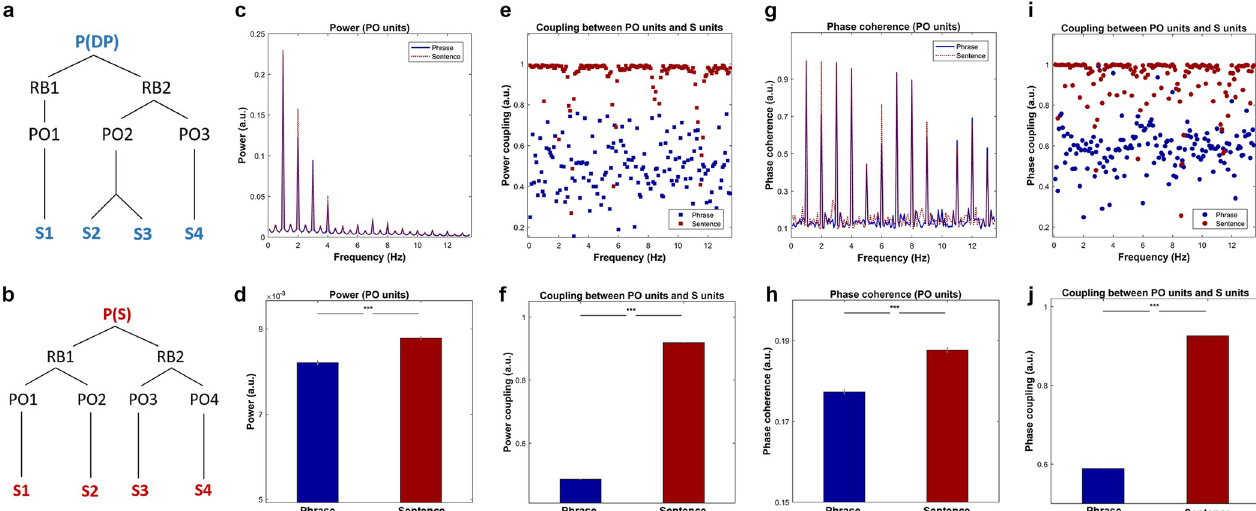
Fig 1. Simulation results based on the time-based binding mechanism. Simulation results based on the time-based binding hypothesis. (a) and (b) The model representation of phrases and sentences, in which the P (Proposition units), RB (Role-filler units), PO (Propositional Object units), and S (syllables units) represent the different types of node in DORA. P(DP) represents the top-level unit is a DP and P(s) represents the highest-level unit is a sentence. (c) Simulation results on power, in which the red dotted line and blue solid line represent the frequency response of the sentences and the phrases, respectively. The shading area covers 2 SEM centered on the mean. (d) Statistical comparison on the frequency combined power using paired sample t test suggested that the power for the sentences was significantly higher than the phrases (t (99) = 8.40, p < 3.25e-13, ��� ). (e) Results of power coupling between PO units and S units, where the red and blue squares show the frequency separated coupling level for the sentences and the phrases, respectively. (f) Statistical comparison on the level of power coupling using paired sample t test suggested that the power coupling level for the sentences was significantly higher than the phrases (t (99) = 251.02, p < 1e-31, ��� ). (g) Results of phase coherence, in which the red-dotted line and blue-solid line shows the phase coherence of the sentences and the phrases, respectively. The shading area represents 2 SEM centered on the mean. (h) Statistical comparison of the phase coherence was conducted using paired sample t test on the frequency averaged response. The comparison indicates that the phase coherence of the sentences was significantly higher than that of the phrases (t (99) = 10.24, p < 1e-20, ��� ). (i) Phase coupling between PO units and S units, the red and blue circles show the level of phase synchronization of the sentences and the phrases, respectively. (j) . Statistical comparison on the level of phase coupling between the phrases and the sentences using paired sample t test suggested that the phase coupling level for the sentences was significantly higher than the phrases (t (99) = 296.03, p < 1e-39, ��� ). DP, determiner phase.